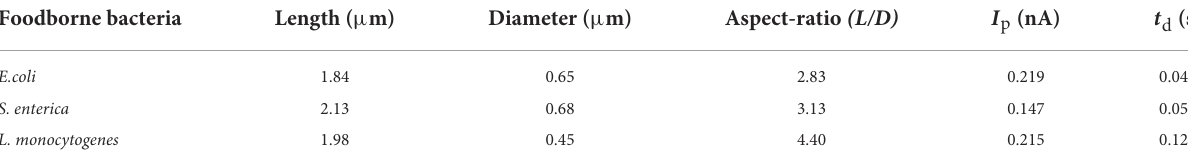
TABLE 1 Shape of three pathogenic bacteria and expected value of current pulse length and width